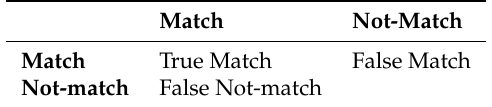
Table 2. Table of the quality assessment for harvest dates